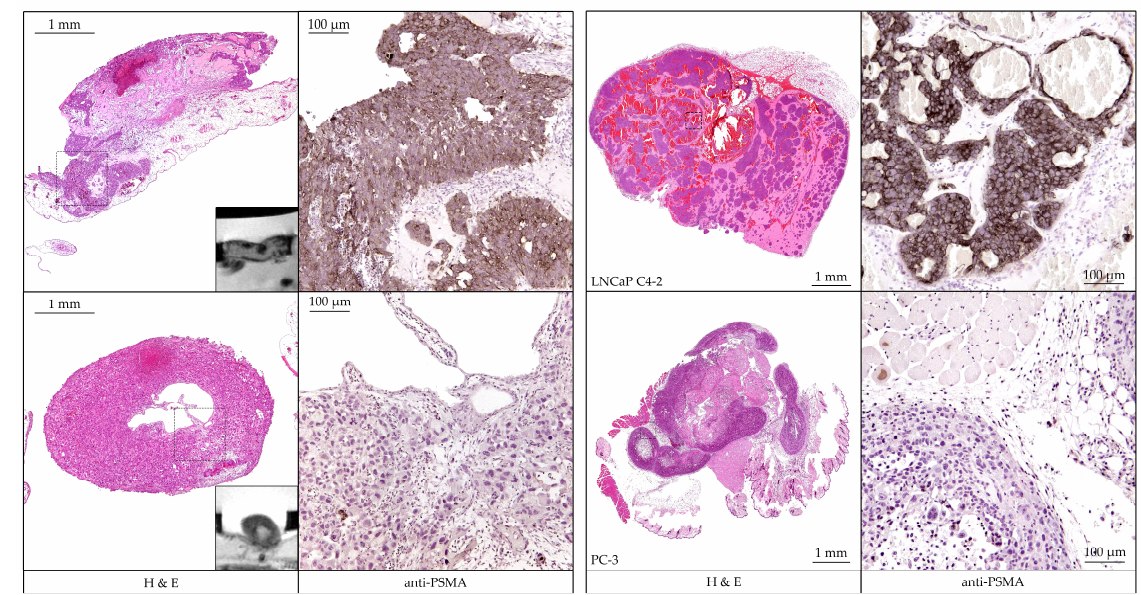
Figure 9. Histopathological analysis of the tumor xenografts grown on the HET-CAM ( left ) and mouse model ( right ). The prostate cancer cell line, based tumors LNCaP C4-2 ( upper row ) and PC-3 ( bottom row ), were stained using hematoxylin and eosin (H&E) as depicted in overview sections ( left side ). Consecutive sections of the same tumors were stained using a PSMA-specific antibody. Detailed images of the section (regions marked with dotted line boxes) are depicted on the right side. Clearly PSMA-specific staining was observed for LNCaP C4-2 but not for PC-3. MR images of the HET-CAM tumors were imaged in addition to the H&E sections to illustrate the excellent resolution of the RARE